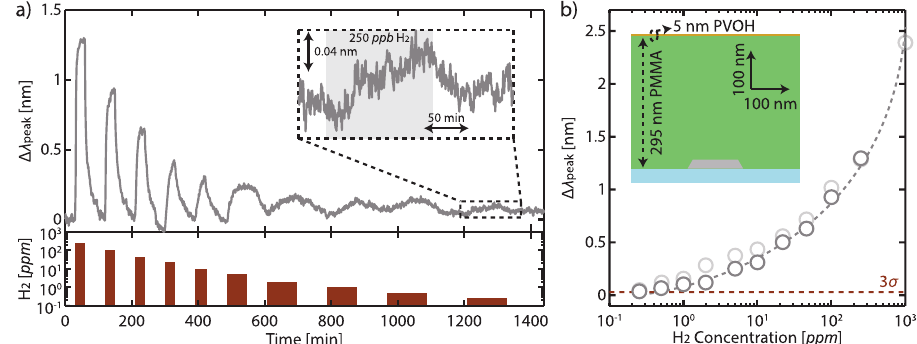
Fig. 5 | Detection in air using a tandem polymer concept. a Δ λ peak response to stepwise decreasing H 2 concentration (1000 – 0.25ppm) diluted in synthetic air at roomtemperature.Inset:zoomed-inversionof thesensorresponseto 250ppbH 2 . b Measured Δ λ peak asafunctionof H 2 concentrationderived from ( a ).Graydashed line is a guide to the eye. Light gray symbols are the response of the optimized